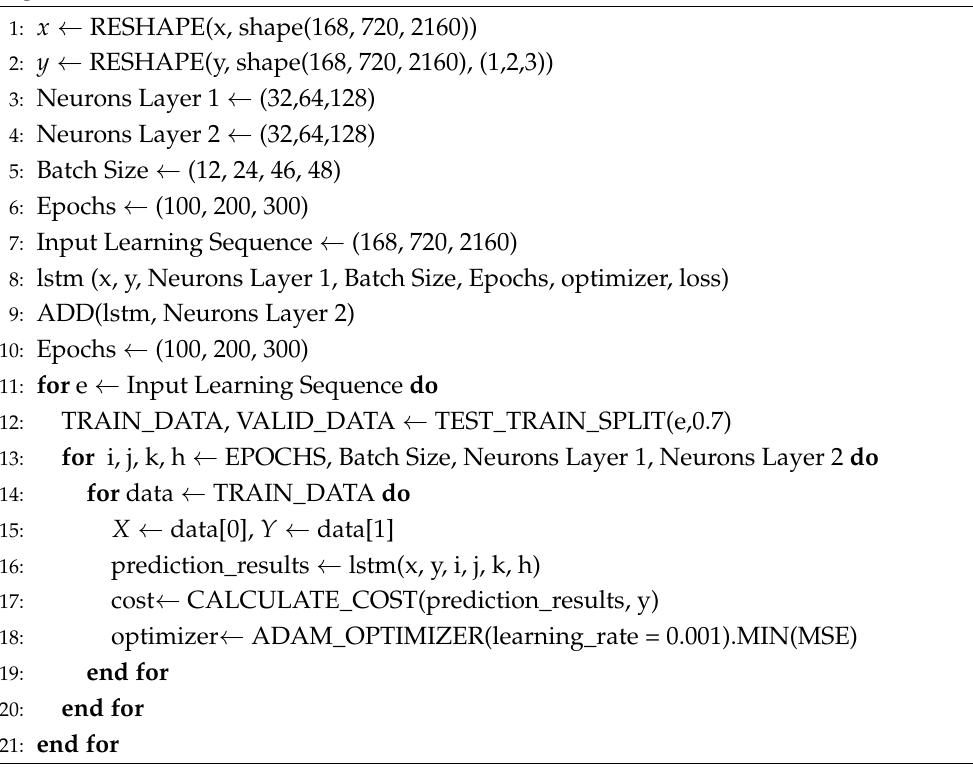
Algorithm 2 Stacked LSTM